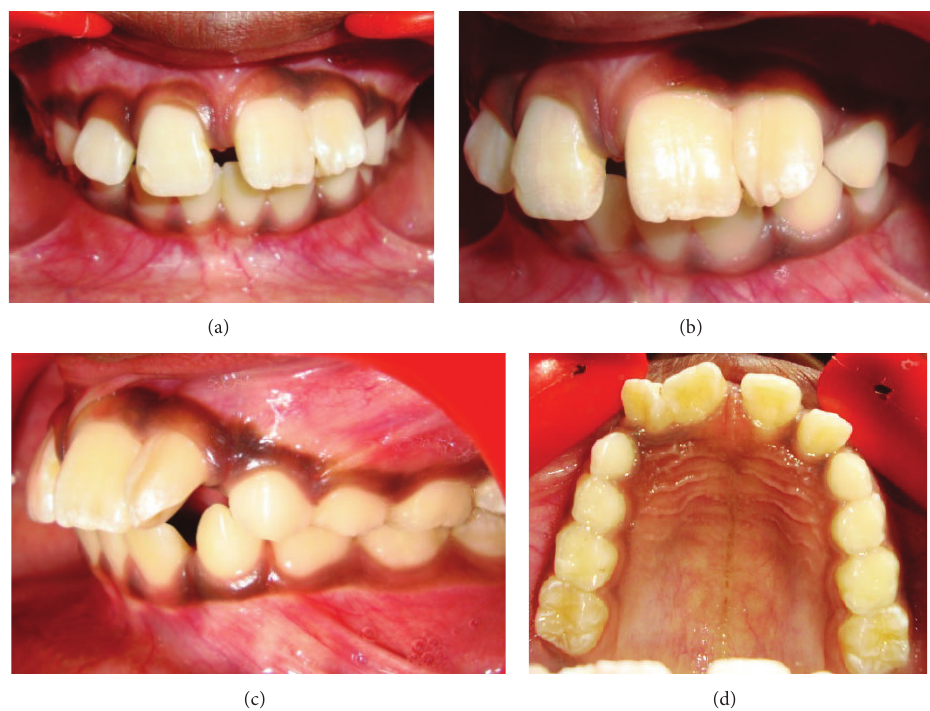
Figure 1: Pretreatment intraoral photos of fused maxillary left central and lateral incisors. (a) Frontal view. (b) Close-up view. (c) Left lateral view. (d) Maxillary occlusal view.